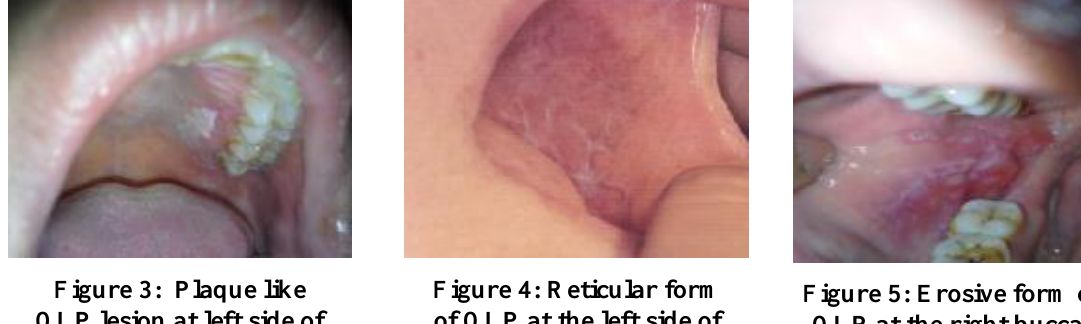
Figure 3: Plaque like Figure 4: Reticular form OLP lesion at left side of of OLP at the left side of palate the buccal mucosa Table 1: Distribution of lesion form factor and gender with Comparisons Significant Lesion Form Freq. & Percents